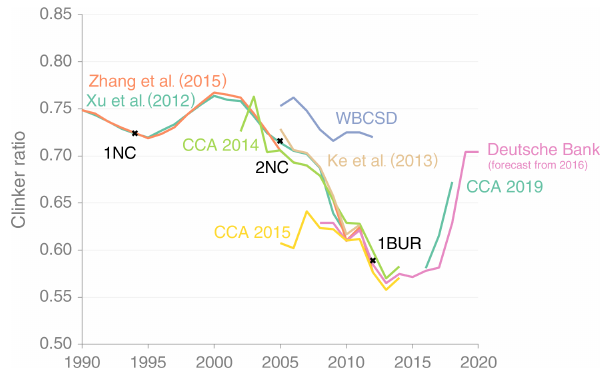
Figure C3. China’s clinker ratio since 1990, from a number of dif- ferent sources. The three official estimates are marked in black: 1NC is the First National Communication, 2NC the Second Na- tional Communication, and 1BUR is the First Biennial Update Re- port. CCA is the Chinese Cement